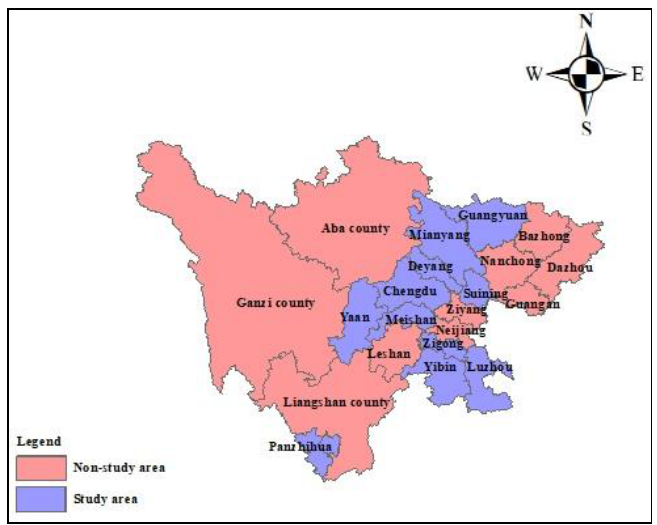
Figure 4. The 11 counties of Sichuan Province selected for this research.